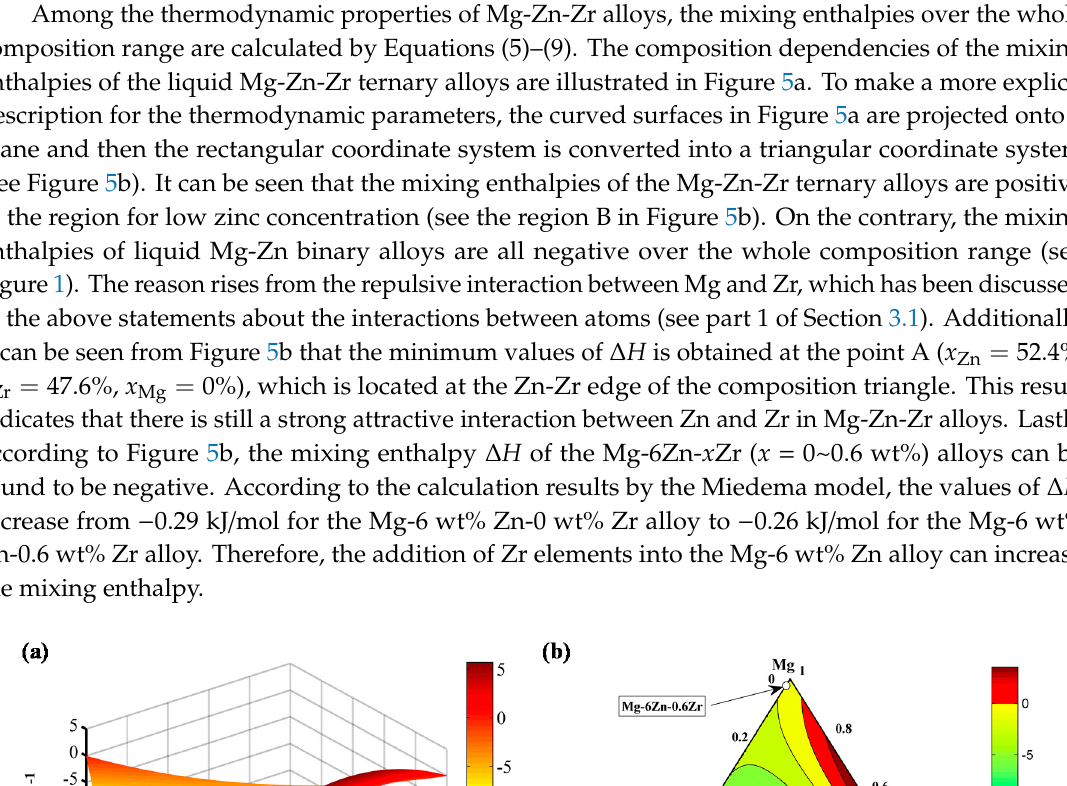
Figure 6. Effect of Zr addition on the activity coefficients of Mg and Zn in Mg-6Zn- x Zr melts at different temperatures. First, it can be seen from Figure 6 that the activity coefficients of Mg and Zn in Mg-6Zn- x Zr ( x = 0–0.6 wt%) alloys are all below 1, which means the activities of Mg and Zn both show negative deviations from ideality. It also implies that Mg and Zn can both precipitate in their ternary alloys.